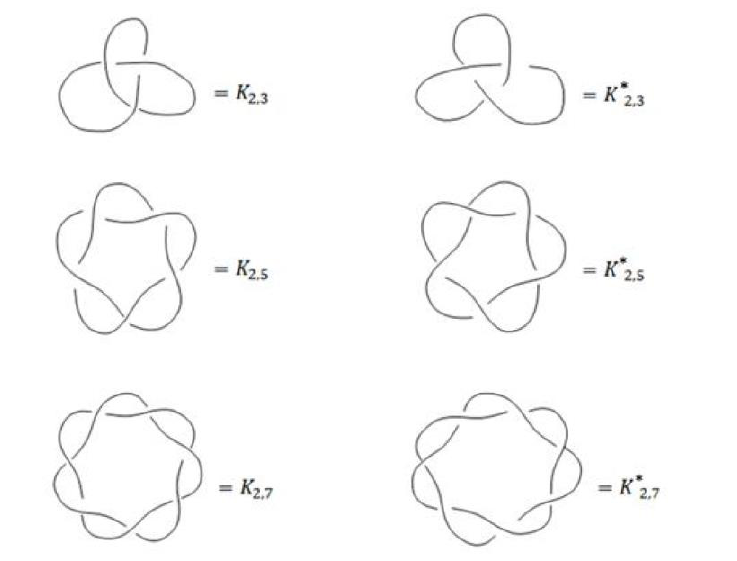
Fig. 2 Regular diagrams of K 2 , n .